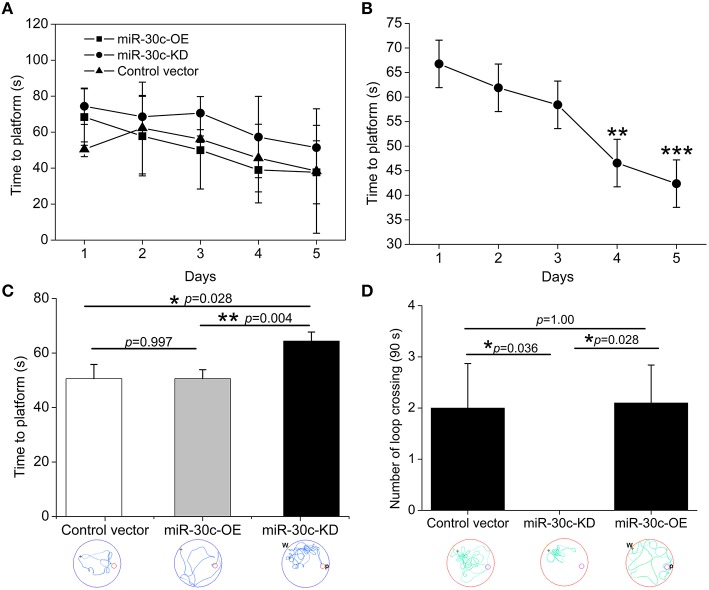
Spatial learning and memory assessment by MWM test. (A) Training-time effects on spatial learning and memory. (B) Statistic analysis the time effect on spatial performances of all animals. **p < 0.01 and ***p < 0.001 determined by two-way ANOVA analysis, with the time and groups as two main effects. (C) Time to the platform location analysis within the five training days. *p < 0.05 and p < 0.01 determined by one-way ANOVA followed by Bonferroni multiple comparison tests; blue lines in the circle, the trajectory of mice during training. (D) Times of crossing the platform location analysis on the 6th testing day. *p < 0.05 determined by one-way ANOVA followed by Bonferroni multiple comparison tests; green lines in the circle, the trajectory of mice during test; W, place of entry; P, location of platform; n = 15 mice, five mice/group.